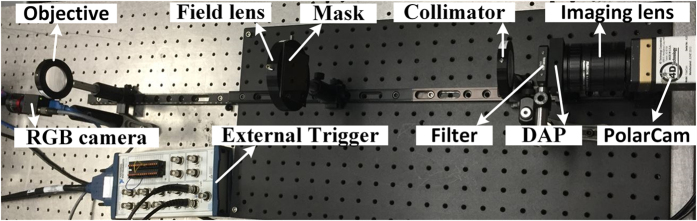
Experimental setup.